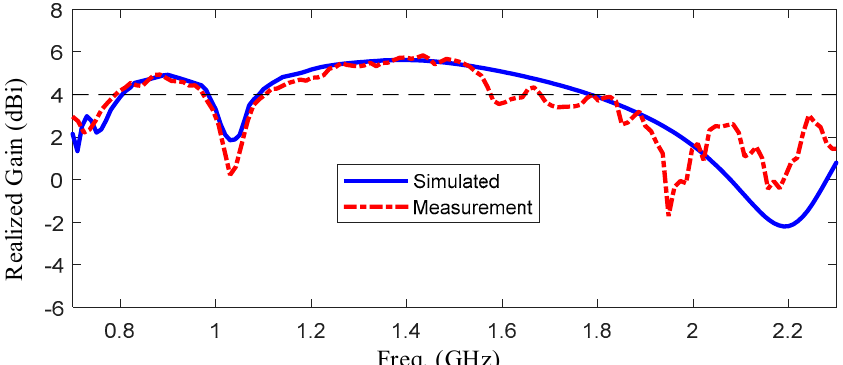
Figure 18. The comparison of realized gain between measurement and simulation.